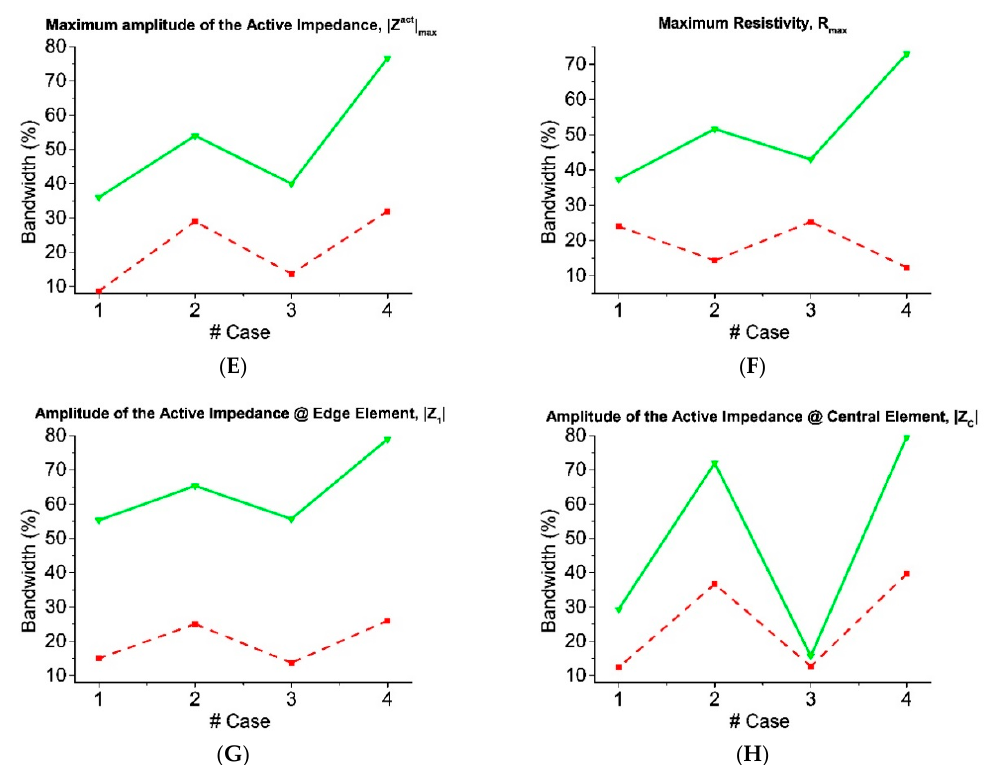
Figure 11. Numerical results of the bandwidth studies where the case numbering corresponds to #1—linear array of half-wavelength dipoles in absence of ground plane, #2—linear array of half-wavelength dipoles in presence of ground plane, #3—resonant linear array in absence of ground plane, #4—resonant linear array in presence of ground plane. Parameters involved in the analysis: ( A ) maximum directivity, ( B ) half-power beamwidth, ( C ) SLL, ( D ) ripple, ( E ) maximum absolute value of the active impedance, ( F ) maximum resistance, ( G ) absolute value of the active impedance of the edge element, ( H ) absolute value of the active impedance of the center element.